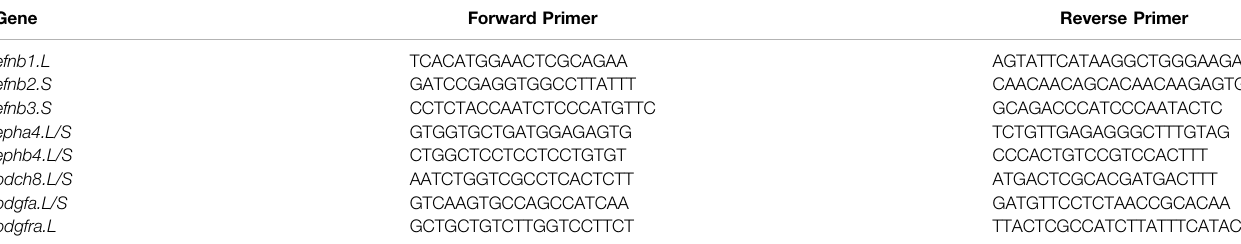
TABLE 1 | Primers for qPCR